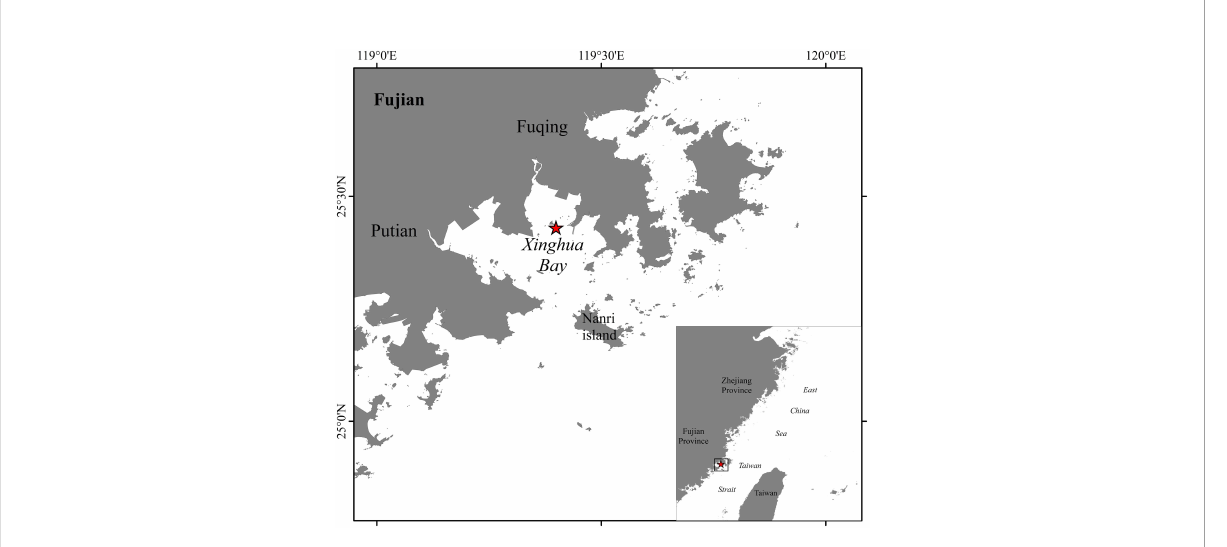
FIGURE 1 Location of biofouling investigation in Xinghua